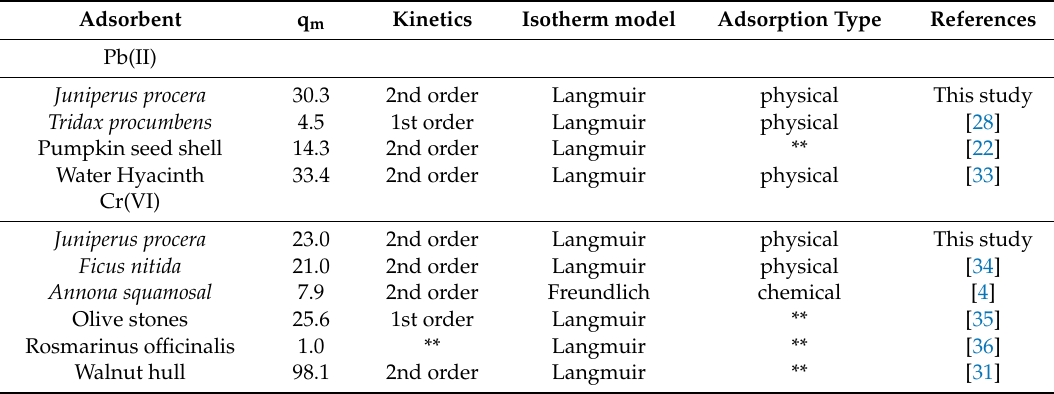
Table 3. Comparison between AAJPL and other activated carbon biosorbent.